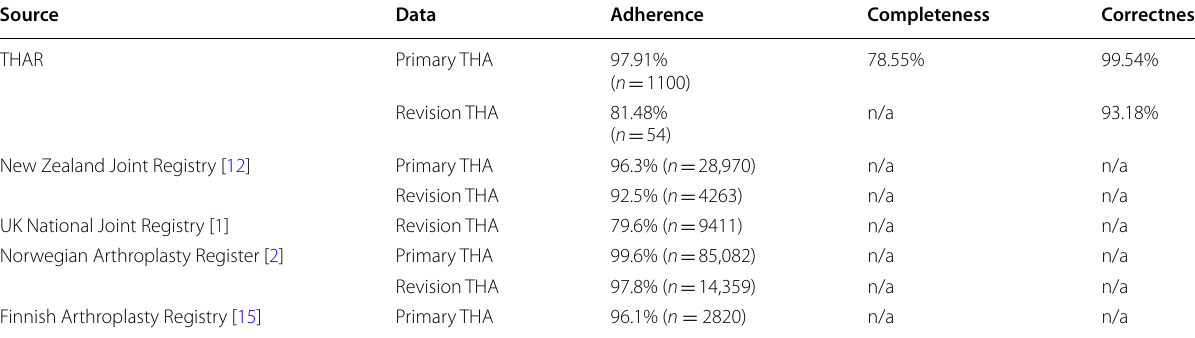
Table 1 Comparison of previous estimates and reported levels of adherence, completeness, and correctness of the THAR